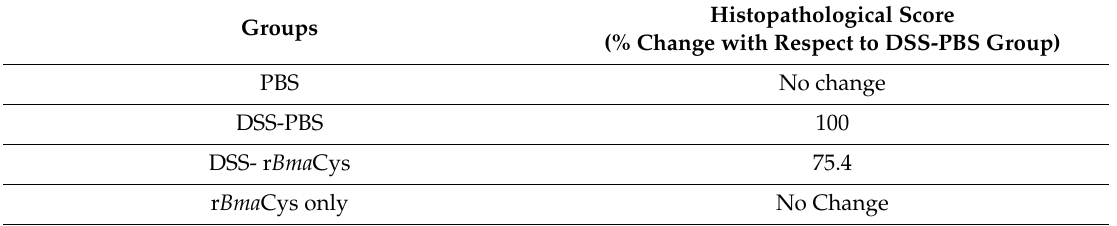
Table 1. Histopathological scoring of colon